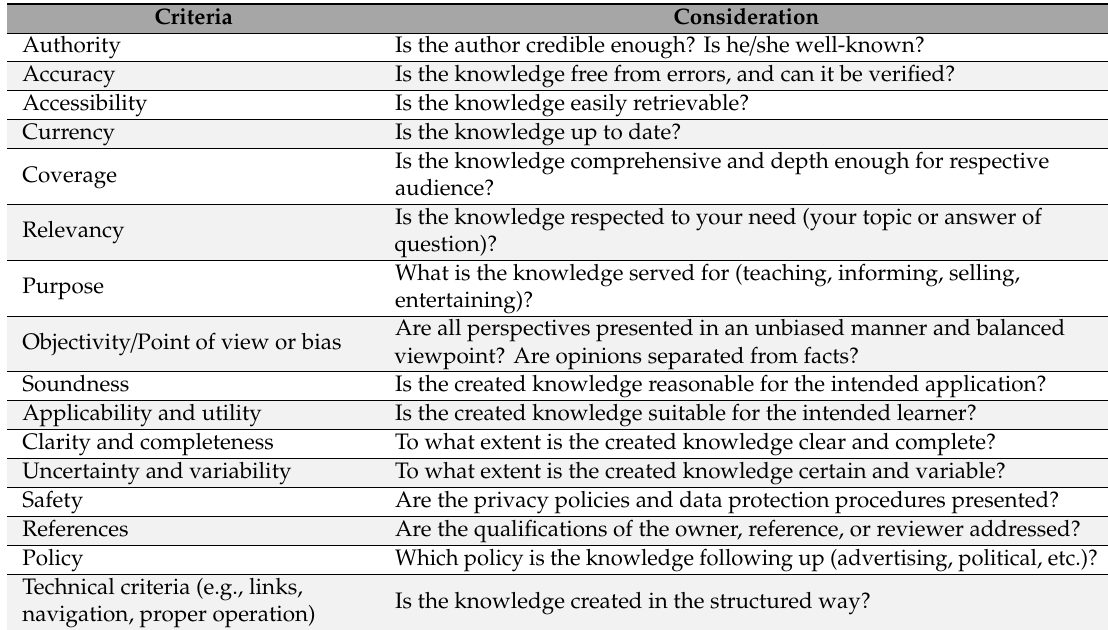
Table 13. Some classic criteria for evaluating created